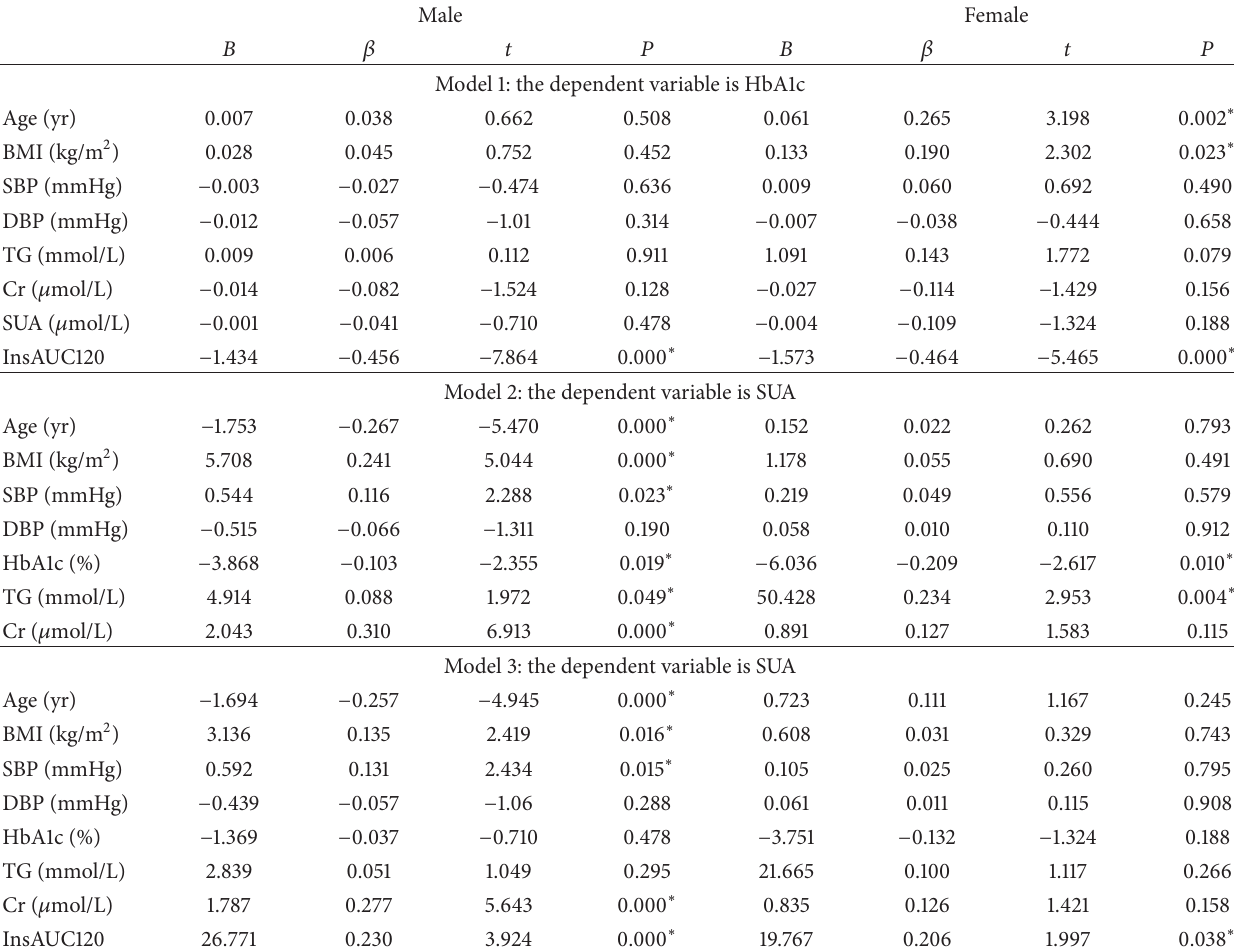
Table 3: Multiple linear regression for SUA, HbA1c, and